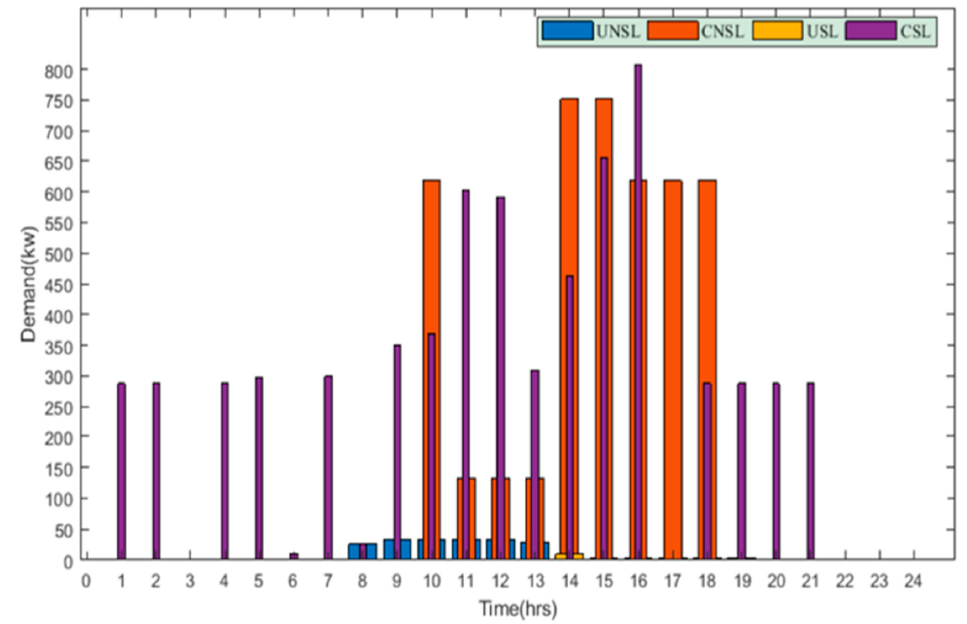
Figure 5. Hourly scheduling of loads based on the four categories of classes.